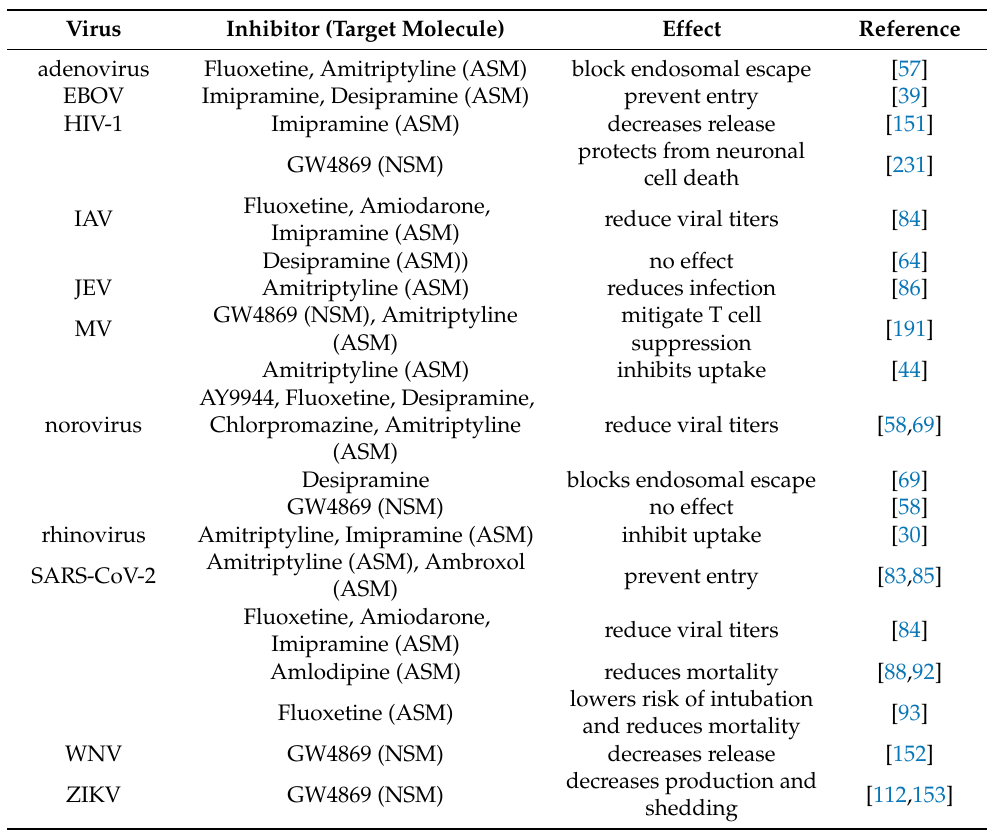
Table 3. Effects of sphingomyelinase inhibitors on different